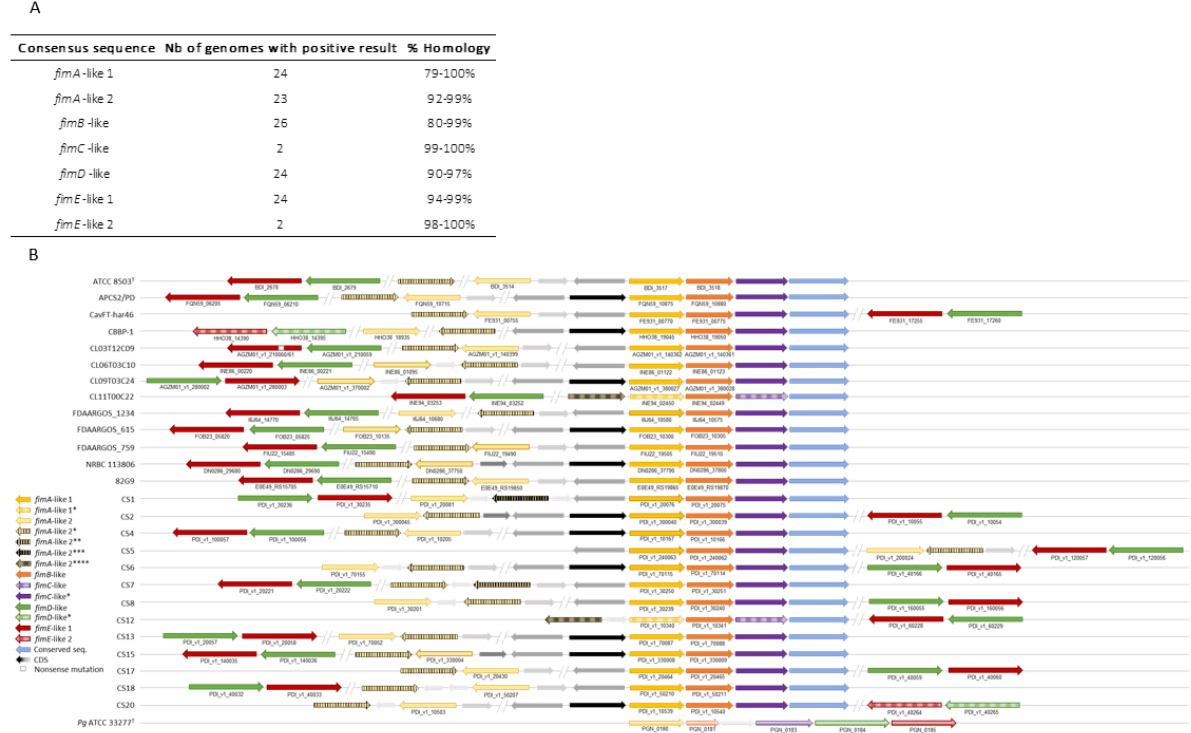
Figure 3. Identification of fim -like gene clusters on P. distasonis genomes compared to P. gingivalis cluster. ( A ) BLAST of fim -like consensus sequences against P. distasonis genomes. ( B ) Syntenic analysis of P. distasonis fimbriae gene clusters centered on fimA -like 1 gene. Vertical striped arrows refer to genes having a high homology and sharing synteny with reference gene. (*) indicate genes with low homology but sharing synteny over P . distasonis genomes. CDS: coding sequences are represented by gray and black arrows. Horizontal striped arrows are used for the Fim cluster of the reference genome: P. gingivalis ATCC 33277 T .